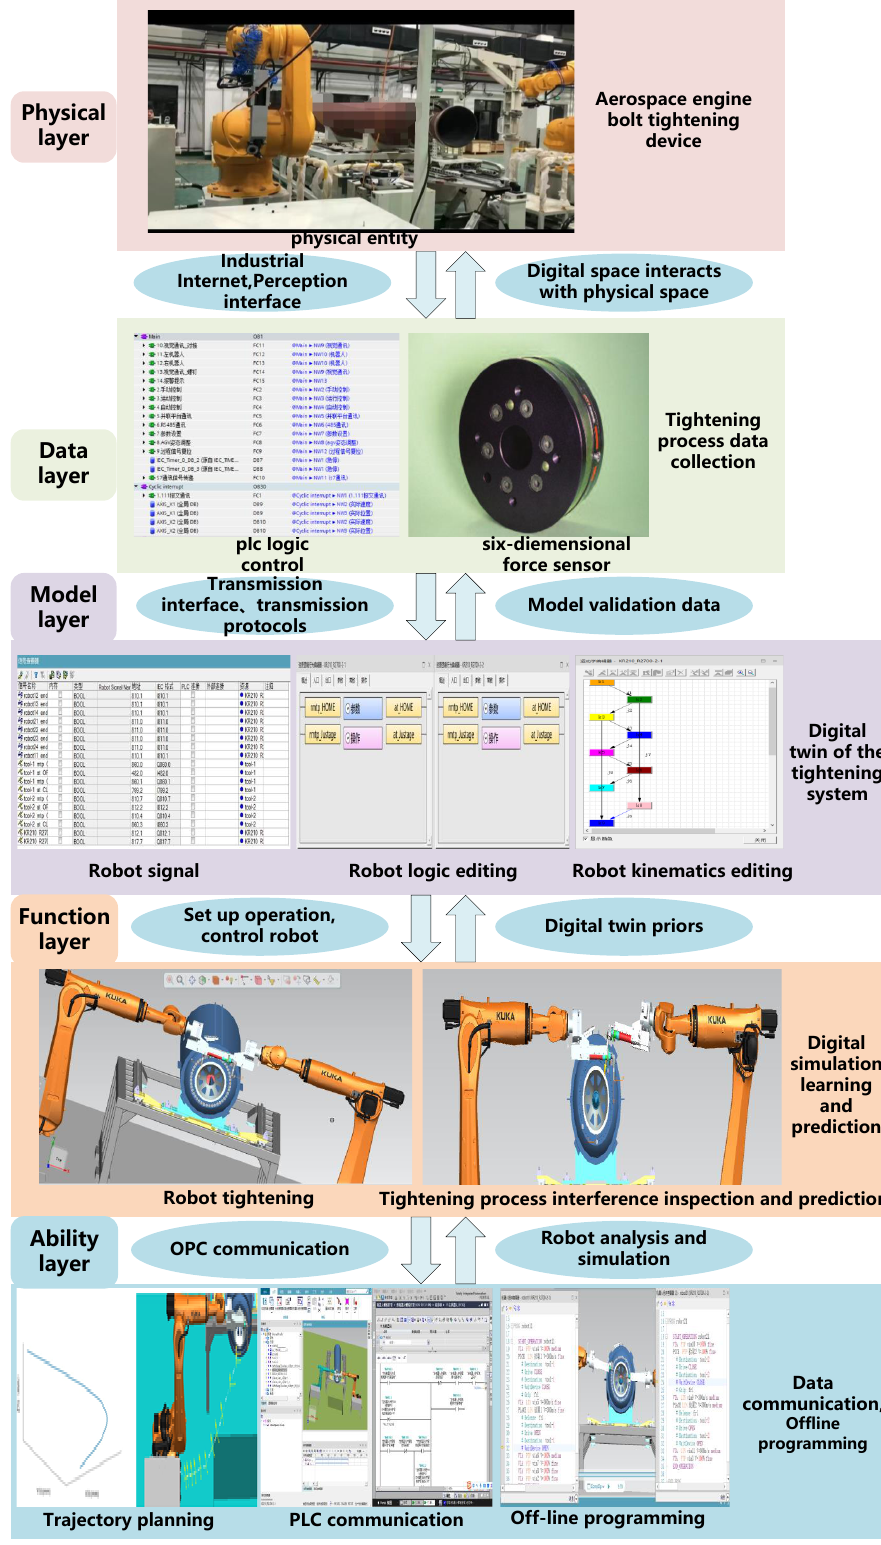
Figure 17. Construction of the digital twin of the tightening